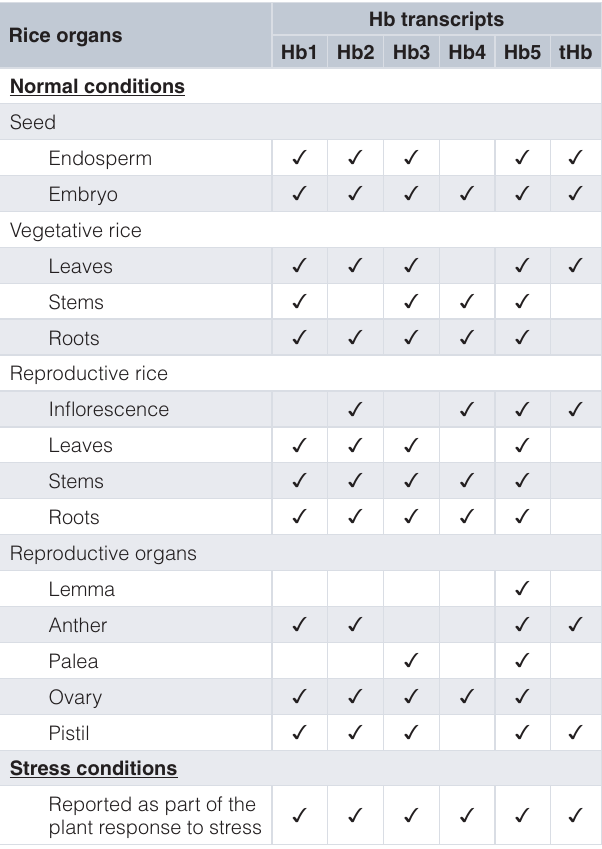
Table 1. Detection of Hb transcripts in organs from rice growing under normal and (cold, drought and salt) stressed conditions. Rice Hb transcripts were detected in plant organs using The Rice Genome Annotation Project database